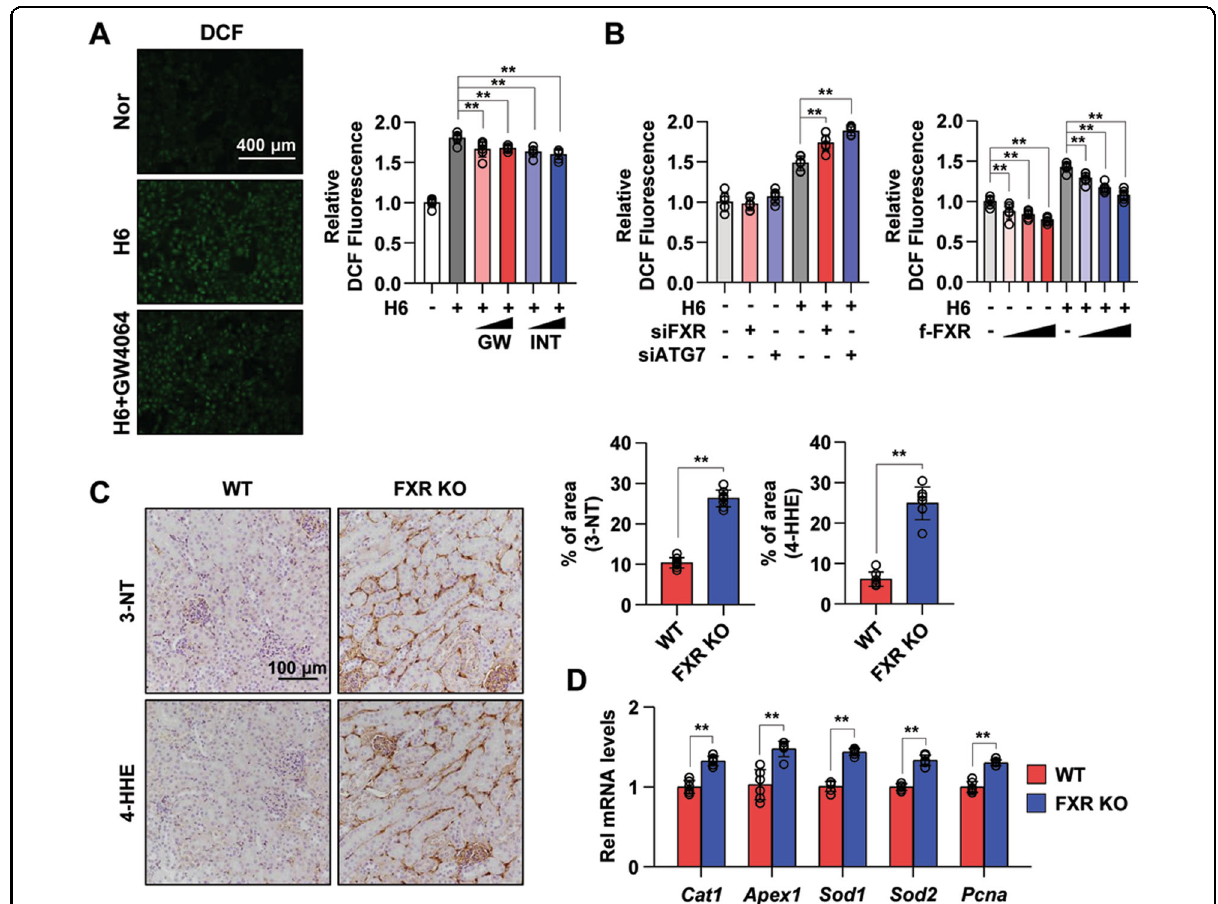
Fig. 6 FXR activation inhibits ROS production. A After treatment with GW4064 (0.5 or 1 μ M) or INT-747 (0.5 or 1 μ M) for 1 h, HK2 cells were exposed to hypoxia for 6 h. The cells were labeled using CM-H 2 DCF-DA, and images were immediately visualized using the EVOS FL Auto Imaging System. Normoxic and hypoxia-exposed cells were incubated with CM-H 2 DCF-DA, and the ROS levels were measured using a Promega GloMax plate reader (right panel). The relative DCF fl uorescence level is shown. The values for normoxia were set to 1 ( n = 6). B HK2 cells were transfected with siFXR and siATG7 (left) or FXR expression plasmids (right) as indicated, and 48 h later, normoxic and hypoxia-exposed cells were incubated with CM- H 2 DCF-DA, and the ROS levels were measured. The values for normoxia of the siControl and vehicle were set to 1 ( n = 6). C Paraf fi